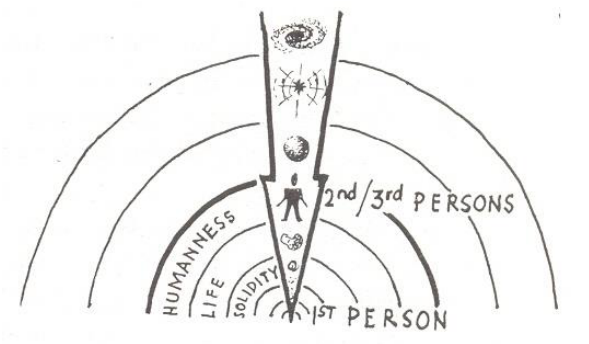
Figure 4. The layers of my appearances [48] (p. 263). Reproduced with permission of the Shollond Trust.